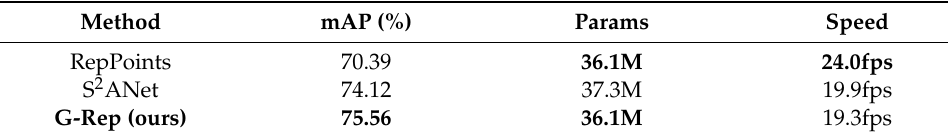
Table 6. Comparison of the time cost on